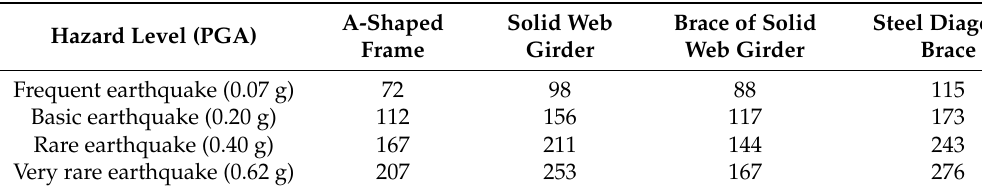
Table 5. Maximum stresses of steel components under different hazard levels (MPa).